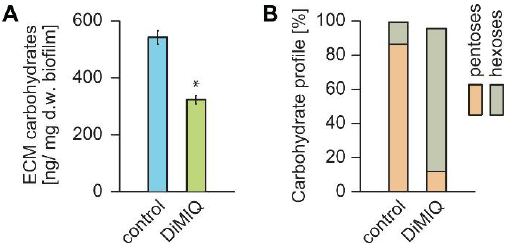
Figure 4. Negative impact of DiMIQ on the C. albicans biofilm extracellular matrix (ECM). ( A ) The presence of DiMIQ dramatically reduced the overall amount of ECM in fungal biofilms by nearly 40%. Mean ± SD values shown. * p < 0.01. ( B ) DiMIQ treatment massively modulated the percentage carbohydrate profile of the ECM by a dramatic reduction in pentoses and a simultaneous increase in hexoses. Mean values shown.